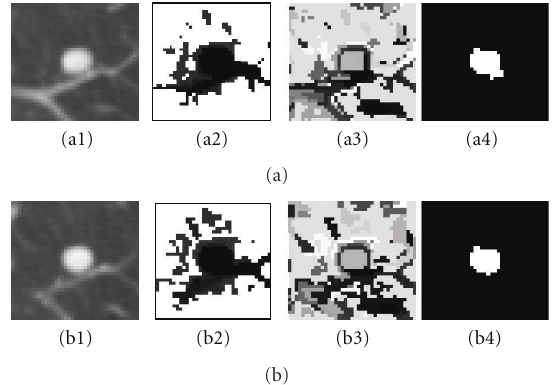
Figure 8: Example of cost functions. (a1, b1) 3D attached nodule in two contiguous slices in CT; (a2, b2) unary cost; (a3, b3) pairwise smoothing cost; (a4, b4) minimization of both energy terms based on